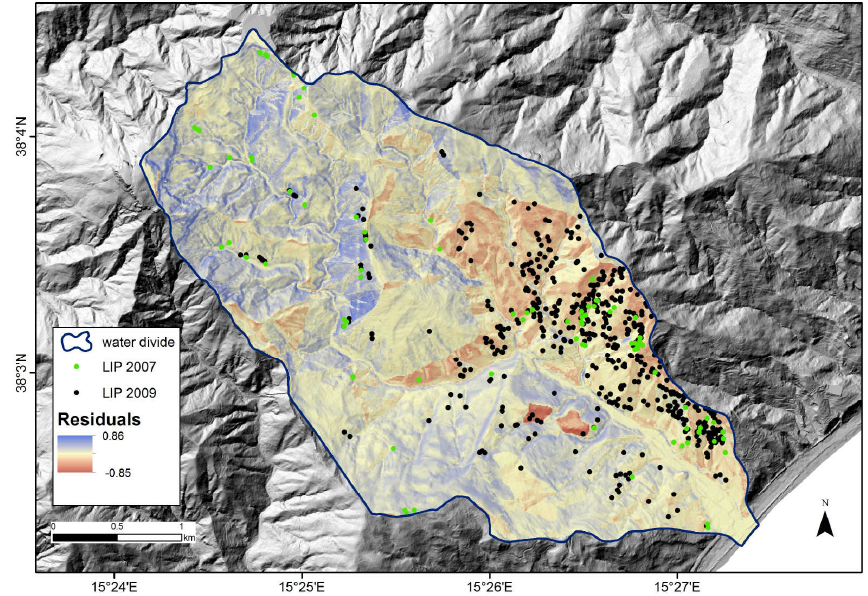
Figure 14. Map of residuals calculated as percentage differences between the two (2007 and 2009) mean susceptibilities.